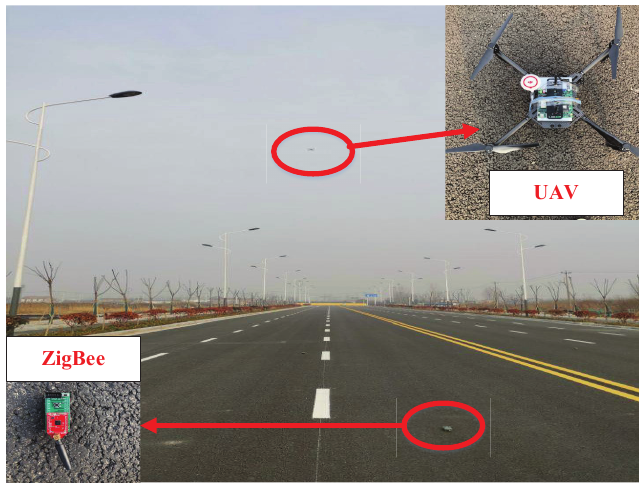
Figure 5. Experimental scene on the